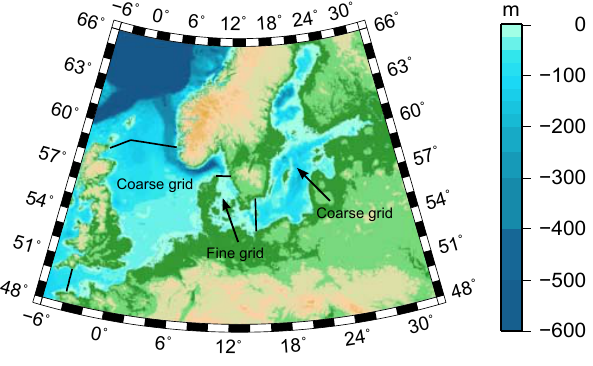
Fig. 1. The two-way nested domain for the physical